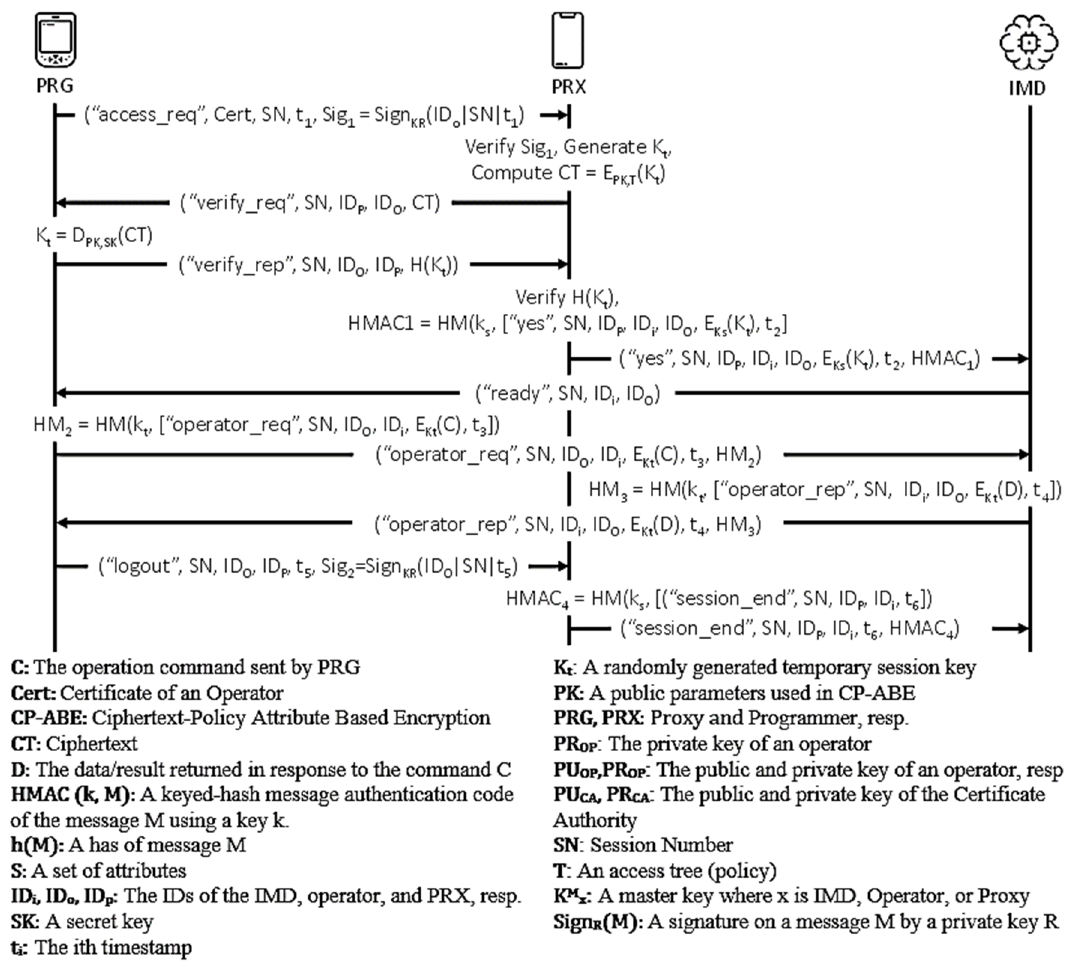
Figure 6. Wu et al.’s protocol.